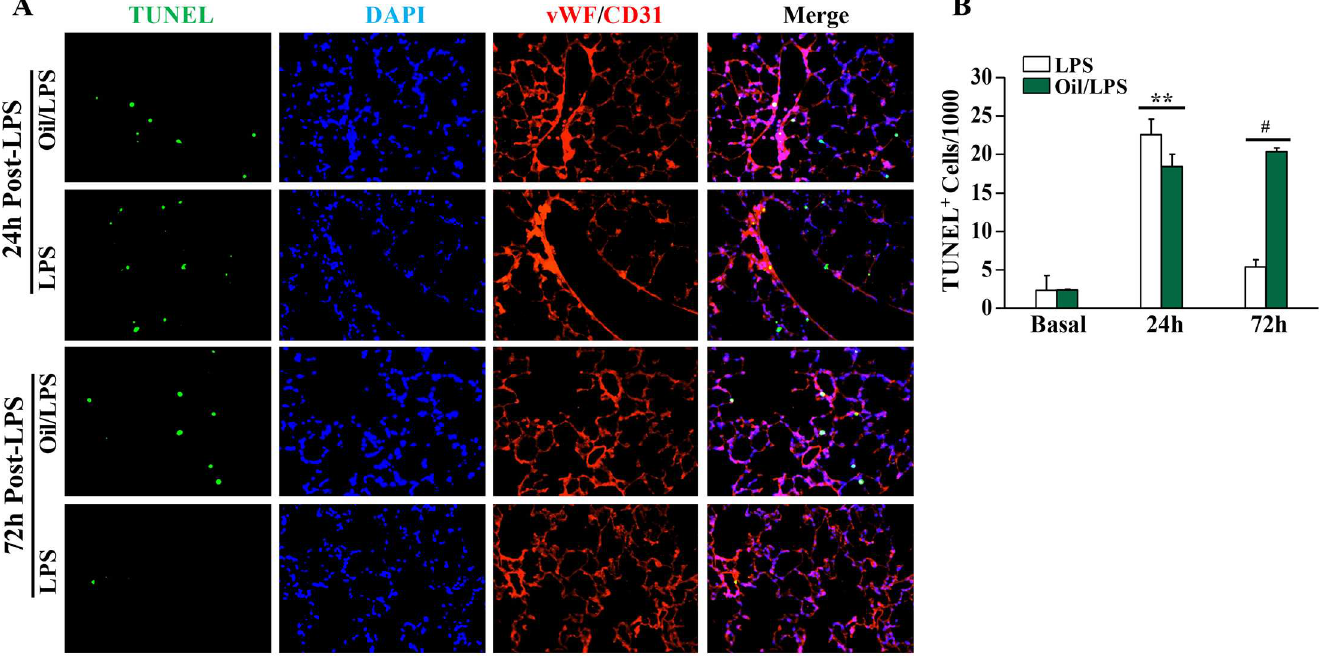
Fig 4. Sustained apoptosis in lungs of oil/LPS-challenged mice. ( A ) Representative micrographsof TUNEL-stained lung sections demonstrating marked increaseof apoptosisat 24 and 72 hours post-LPS challengein oil-loadedmice whereasapoptosiswas prominentat 24 hours but minimalat 72 hours post-LPS in oil-free mice. In Situ Detection of Cell Death kit was employedto immunostainapoptotic cells (green) whileanti-vWF and -CD31 antibodies(red) were used to co-immunostain vascular ECs. Nuclei were counterstained with DAPI (blue). Scale bar, 50 μ m.( B ) Quantification of apoptosis.Data are expressedas mean ± SD (n = 4/group). ** , P < 0.01; #, P < 0.001.